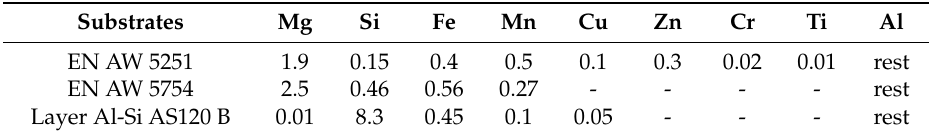
Table 1. Chemical composition (wt.%) of aluminum-magnesium substrates and the aluminum-silicon layer of aluminized steel.